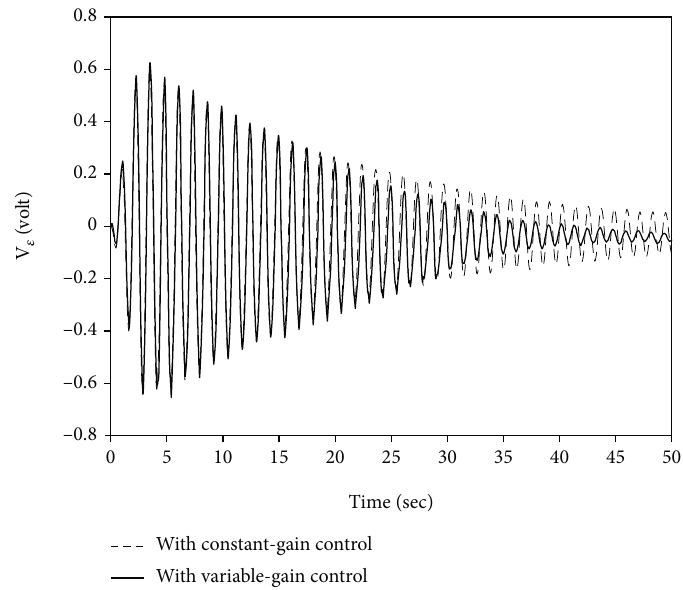
Figure 11: Measured response curve of the strain voltage with variable-gain